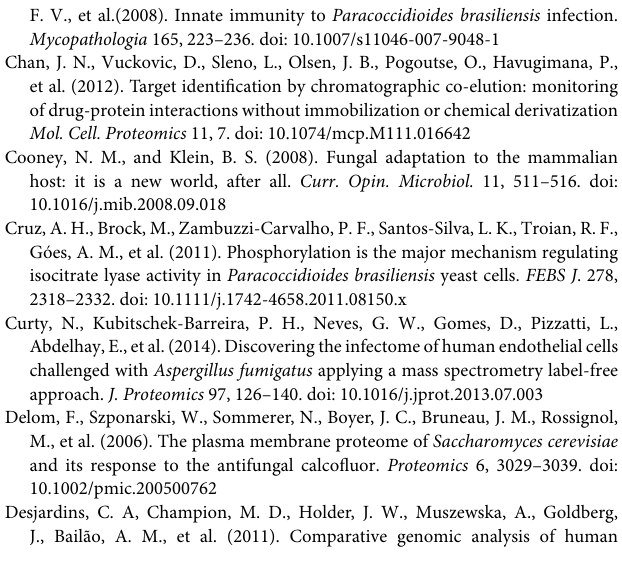
(3) P. lutzii (Pl) + argentilactone (Al) + ø; (4) P. lutzii (Pl) + sulfamethoxazole (S); (5) P. lutzii (Pl) + sulfamethoxazole (S) + ø; (6) P. lutzii (Pl) + ø. Data were normalized to the tubulin transcript. Data were analyzed by a One-Way ANOVA and a Tukey’s multiple comparison post-test. * p ≤ 0 . 05